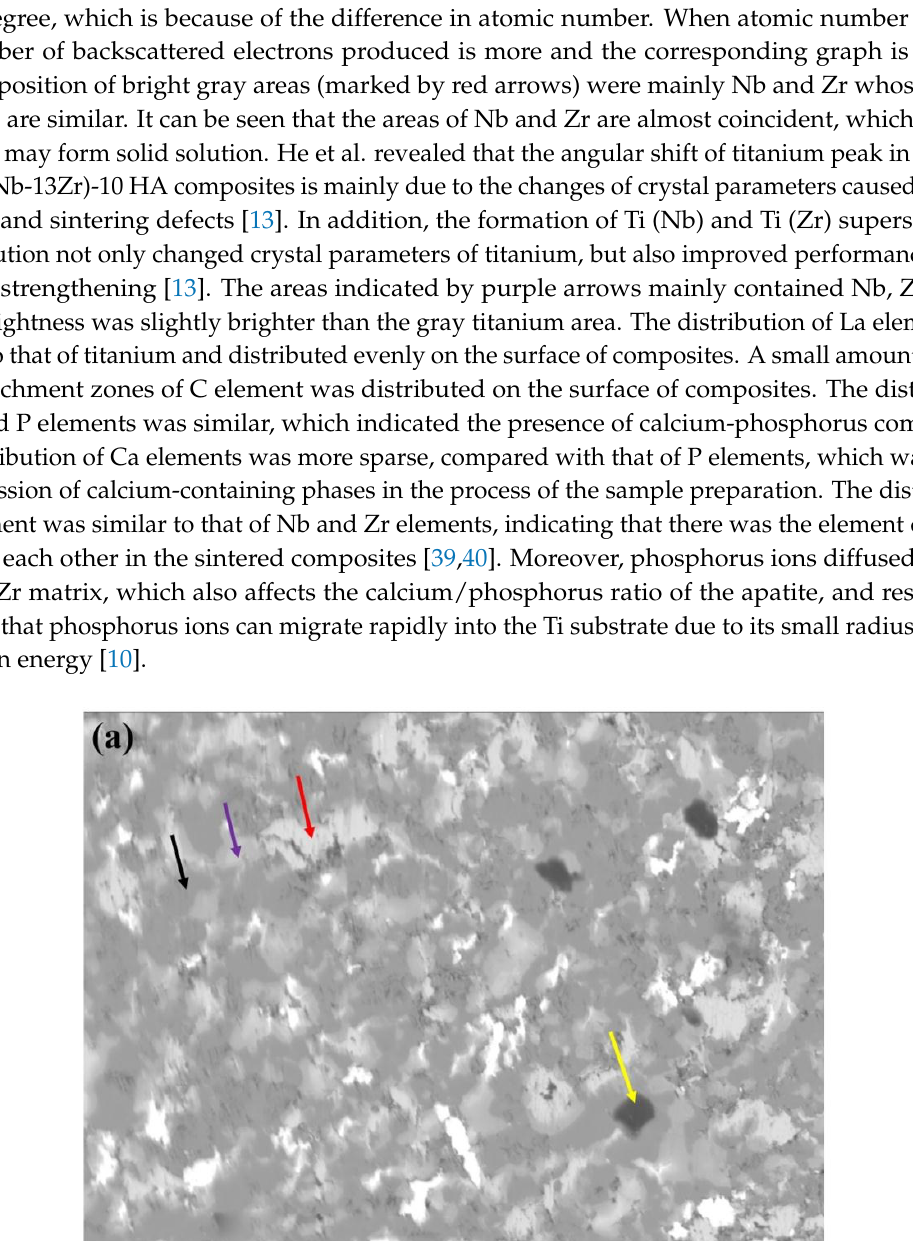
Figure 6. ( a ) SEM micrographs of the 0.5-GNFs nanocomposite sintered at 1000 °C. The corresponding mapping scanning results of EPMA: ( b ) Ti; ( c ) Ta; ( d ) Nb; ( e ) Zr; ( f ) P; ( g ) Ca; ( h ) C; and ( i ) La. According to the Siegbahn nomenclature, Kalpha 1 and Lalpha 1 refers to the name of the electronic